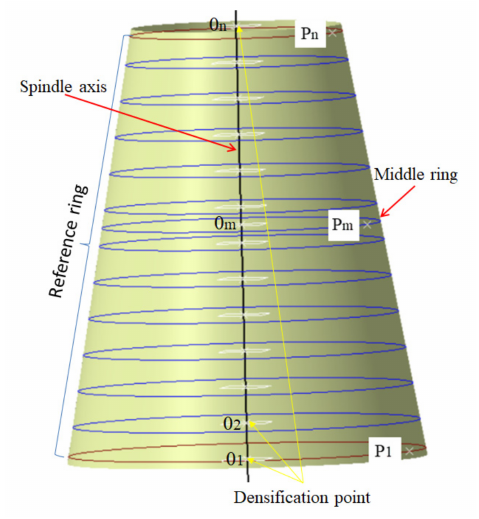
Figure 2. Construction of the initial